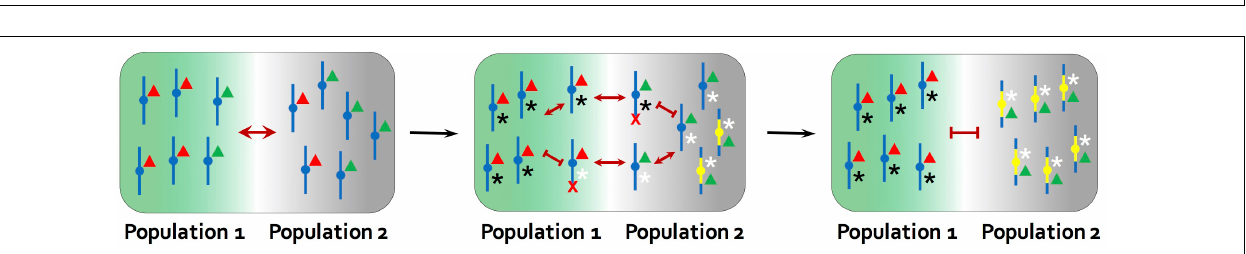
FIGURE 3 | Results of local population structure analyses in (A) Helianthus petiolaris (data from Huang et al., 2019), (B) H. bolanderi (data from Owens et al., 2016), and (C) H. niveus (data from Zhang et al., 2019). Variant calling and multidimensional scaling (MDS) follow the same methods described in Huang et al. (2019). Only the first MDS coordinate is plotted. Clusters of MDS outliers, which indicate putative inversions (and have been confirmed with other methods), are identified in H. petiolaris (indicated with dotted circles) but not in the other two species.